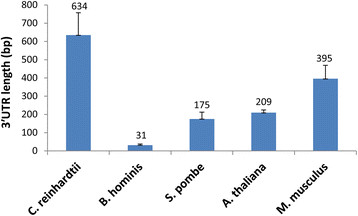
Average length of the 3′ untranslated region (UTR) of 10 mRNA sequences per species forChlamydomonas reinhardtii(alga),Blastocystis hominis(protozoan parasite),Schizosaccharomyces pombe(fission yeast),Arabidopsis thaliana(Arabidopsis), andMus musculus(mouse). Note that the 3′UTR length varied greatly among species, but there is no mixture between the poly(A) site signature motifs presented in Figure 8 and stop codons.